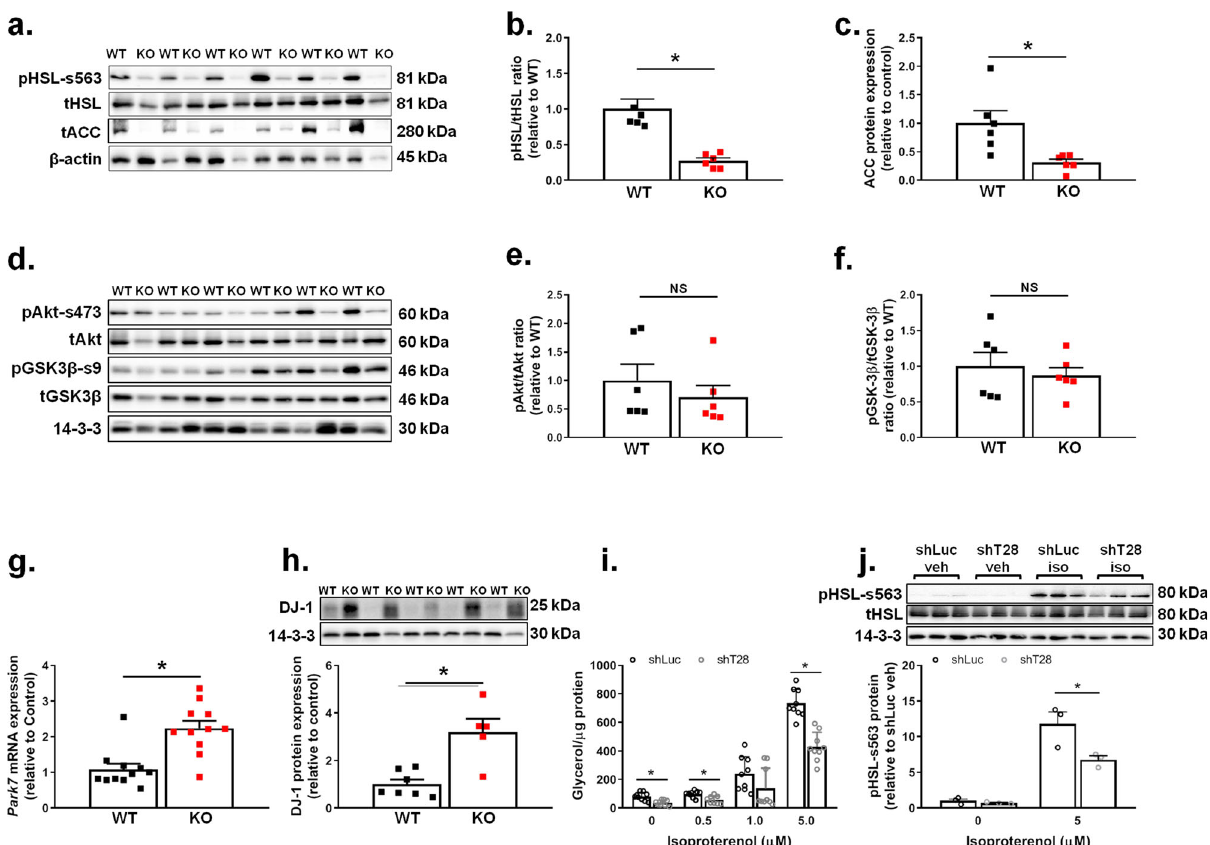
Fig. 6 Trim28 adi-KO mice demonstrate altered pathways associated with adipocyte lipid storage and metabolism. Protein analyses performed in gonadal fat pads from Trim28 wild type (WT) and adipose-speci fi c Trim28 KO (KO) female mice fed a HFD. a Western blot from WAT of HFD-fed mice for serine 563 phosphorylation of HSL (pHSL-s563), total HSL (tHSL), total ACC (tACC), and beta-actin ( β -actin). Densitometry quanti fi cation is shown for ( b ) HSL phosphorylation at serine 563 and ( c ) total ACC, ( n = 6/group) * p < 0.05 versus WT mice. d Western blot from WAT of HFD-fed mice for serine 473 phosphorylation of Akt (pAkt-s473), total Akt (tAkt), serine 9 phosphorylation of GSK-3 β (pGSK-3 β -s9), total GSK-3 β (tGSK-3 β ), and 14-3-3 (14-3-3). Densitometry quanti fi cation is shown for ( e ) Akt phosphorylation at serine 473 and ( f ) GSK-3 β phosphorylation at serine 9, ( n = 6/group for each). g mRNA expression of Park7 (DJ-1, n = 11/group), and ( h ) DJ-1 protein expression as determined by western blot (above, n = 6), * p < 0.05 versus WT mice. Glycerol release and HSL serine 563 phosphorylation were measured in control (shLuc) and Trim28-depleted (shTrim28) 3T3-L1 cells in response to isoproterenol treatment (0 – 5 µ M) as a measure of lipolysis. i Glycerol release normalized to mg protein in shLuc and shTrim28 3T3-L1 adipocytes at day 8 post differentiation stimulated with 0, 0.5, 1, and 5 µ M isoproterenol ( n = 9/group). j HSL serine 563 phosphorylation as determined by western blot (above) normalized to total HSL and relative to shLuc vehicle (veh: 0 µ M) in shTrim28 3T3-L1 adipocytes. * p < 0.05 versus shLUC, n = 3/group in triplicate. All data are presented as mean ± SEM. All data were analyzed by ANOVA with post hoc testing (Fisher ’ s LSD). ACC acetyl-CoA carboxylase, HSL hormone-sensitive lipase, DJ-1 protein and nucleotide deglycase